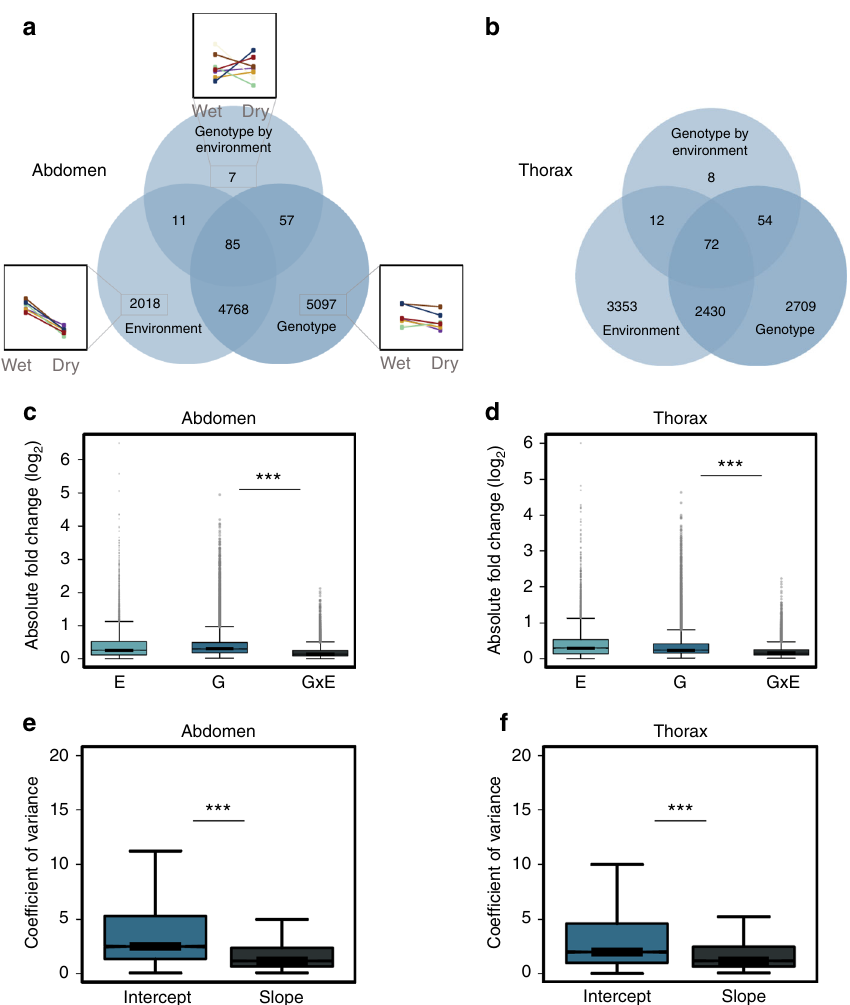
Fig. 3 Large-scale reduction of genetic variation for seasonal plasticity across the transcriptome. a , b An order of magnitude more genes show signi fi cant differential expression due to seasonal environment and genetic background than due to the interaction between environment and genetic background for abdomen ( a ) and thorax ( b ). Within each Venn diagram, numbers of differentially expressed genes (FDR < 0.05) are indicated for seasonal environment (left), genetic background (right), and their interaction (top), as well as overlap in responses among genes. Small insets in a illustrate expression patterns for each gene group, showing mean normalised expression in wet and dry season for random genes in each group, with reaction norms for different full-sib families represented by different colours. c , d Across all genes in the abdomen ( c ) and thorax ( d ) transcriptome, mean absolute expression changes (log 2 fold change) due to the interaction between environment and genetic background (i.e., transcriptional plasticity or GxE; right boxplot) are 43 – 51% smaller than those due to genetic background (i.e., genetic variation for average expression or G; middle boxplot; *** P < 0.0001). Only 120 and 88 transcripts (in abdomen and thorax, respectively) showed more than a twofold expression change as a result of inter-family differences in plasticity, compared to 1054 and 766 transcripts above that threshold for inter-family difference in average expression. e , f Families are more similar in how expression responds to the environment than in average expression levels, with reaction norms for expression of all genes showing on average 57 and 32% lower across-family variance in slope (right, black) than in intercept (left, blue) for abdomen ( e ) and thorax ( f ), respectively (*** P < 0.0001). P -values are for two-sample Wilcoxon signed-rank tests (two-sided). Upper whiskers are at the upper quartile plus 1.5× the interquartile range or at the maximum value (whichever is lowest), whereas lower whiskers extend to the lower quartile minus 1.5× the interquartile range or to the minimum value (whichever is that for many genes, expression in one season is genetically Fourth, analysis of reaction norms in gene expression revealed coupled with expression in the other season, and there is limited that families are much more similar in how expression responds genetic variation for expression that is independent between the to the environment than in their average expression levels. We computed family-speci fi c seasonal reaction norms, comparing across-family variance in slope (plasticity) and intercept (average expression), and found that variance in slope was 57 and 32% lower than variance in intercept, for abdomen and thorax − 16 ). respectively (Fig. 3e, f; Z > 36, P < 10 Finally, we observed high-positive genetic correlations in gene expression across seasonal environments (Supplementary Fig. 10), with median Spearman Rank correlations of + 0.67 and + 0.47, for abdomen and thorax, respectively. This indicates